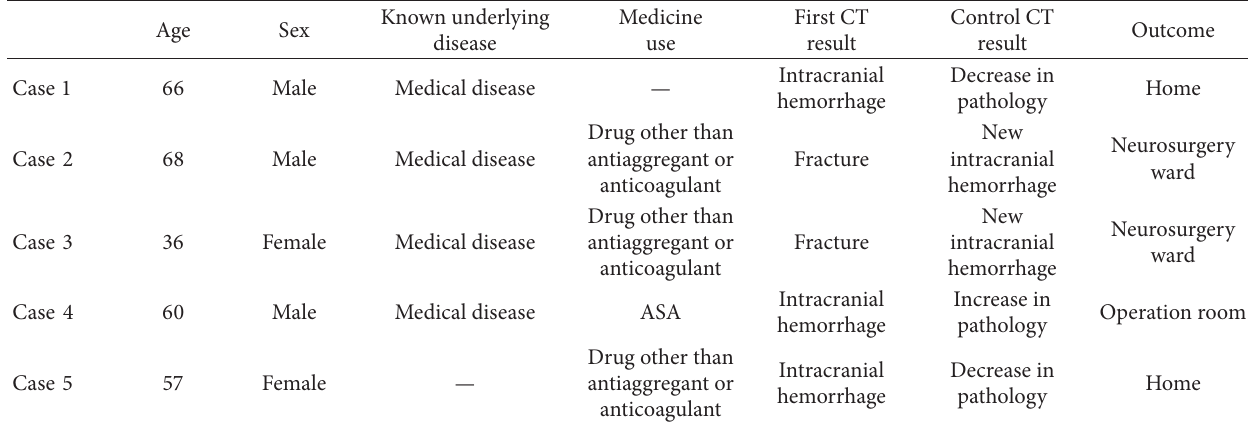
Table 2: General characteristics of patients who had change of pathology in control cranial